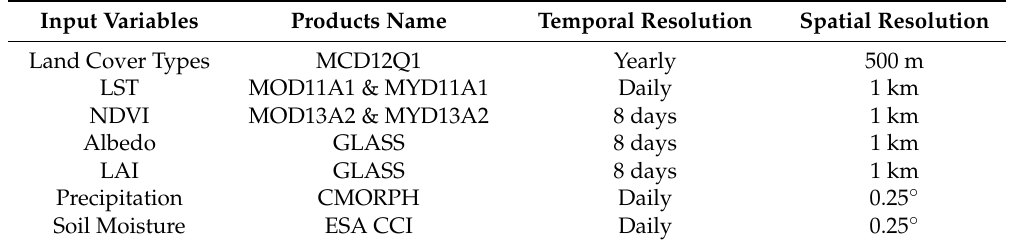
Table 1. Main input remote sensing dataset for evapotranspiration (ET) estimation.